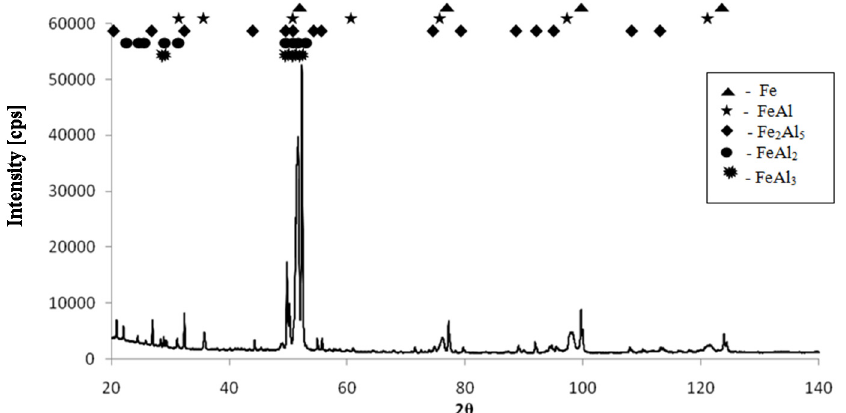
Figure 4. The exemplary XRD pattern of material after the sintering process (Fe–45Al–3 wt% MC).